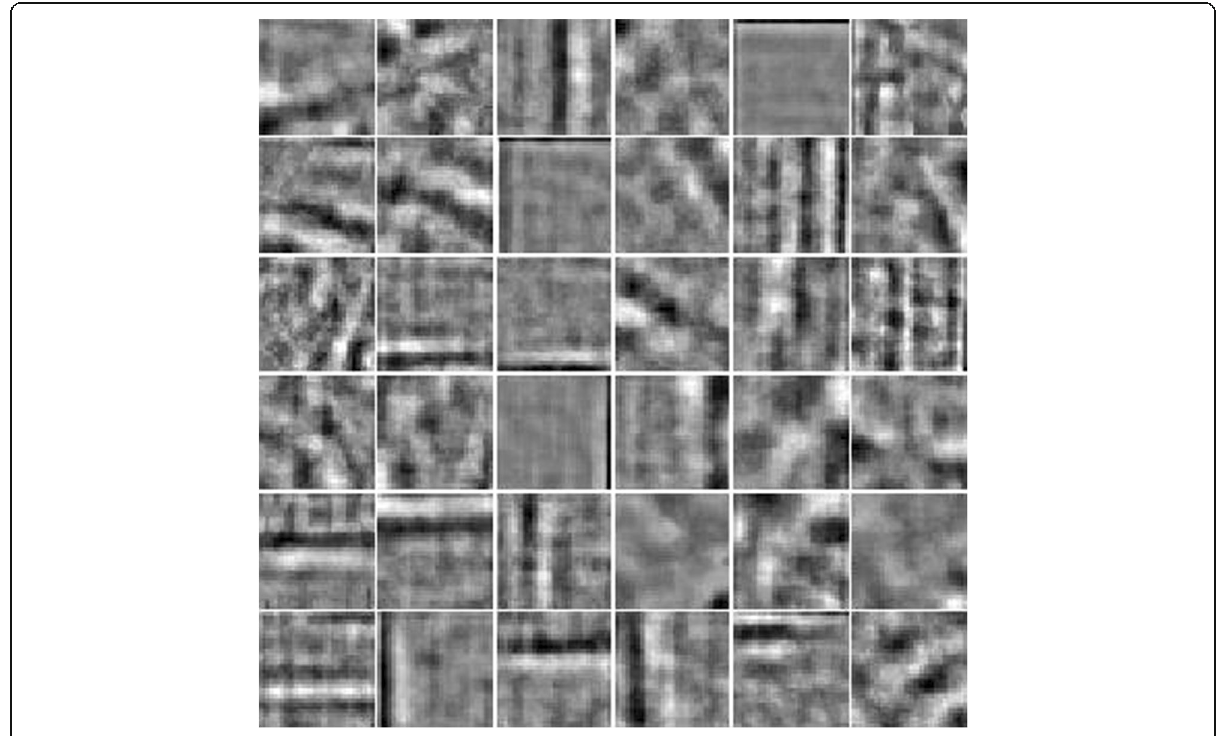
Fig. 4 36 W i s are obtained by the FastICA